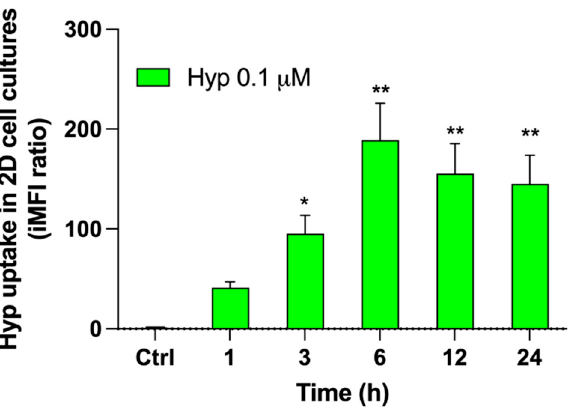
Figure 2. Hypericin uptake in 2D HT-29 cell cultures. HT-29 cells were incubated for 1, 3, 6, 12, and 24 h with 0.1 µ M Hyp. Fluorescent signals were detected using a flow cytometer at 488 nm excitation to measure the intracellular amount of Hyp that was expressed as iMFI ratio versus untreated cells (Ctrl). Statistically significant difference versus untreated cells (Ctrl): * p ≤ 0.05, ** p ≤ 0.01 ( n = 3).